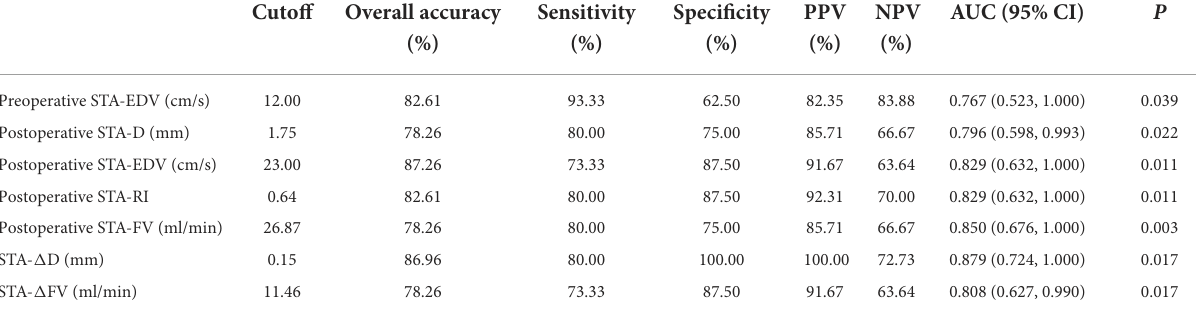
TABLE 7 The cutoff values and AUC for the collateral development after EDAS.